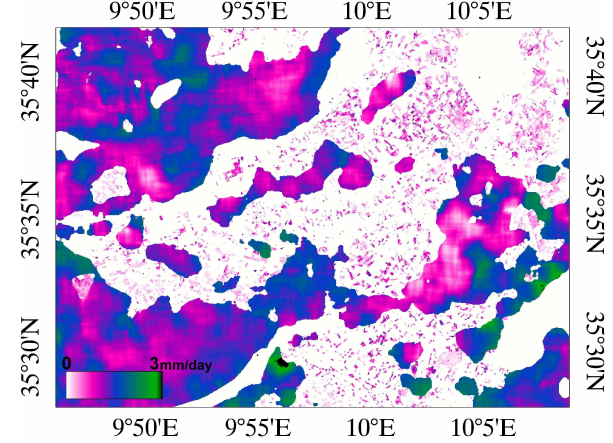
Fig. 13. Example of soil evaporation mapping over olive tree and wheat classes of land use on 7 March